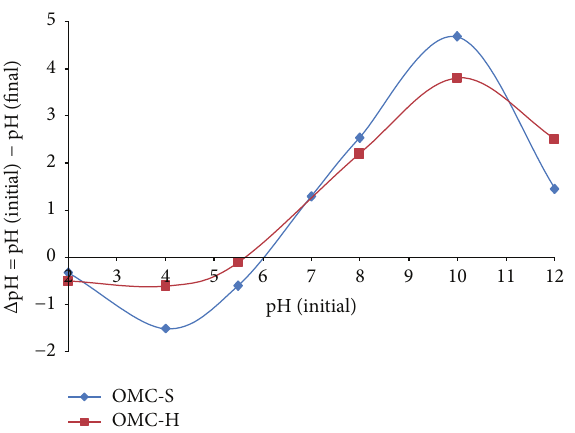
Figure 4: pH pzc plot of OMC-S and OMC-H.